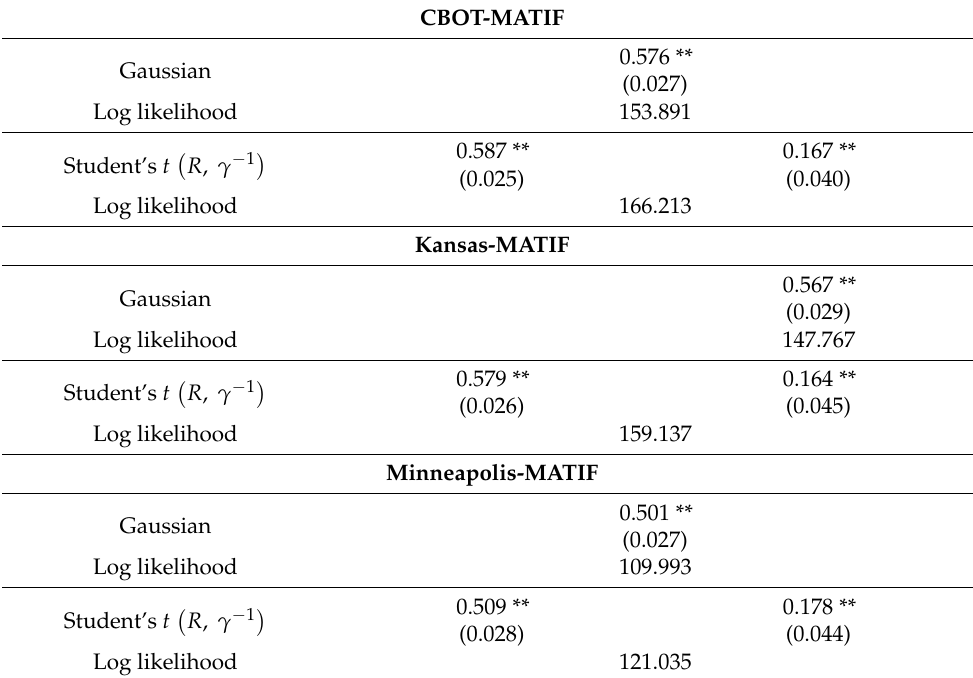
Table 9. Results from static copulas for the first period